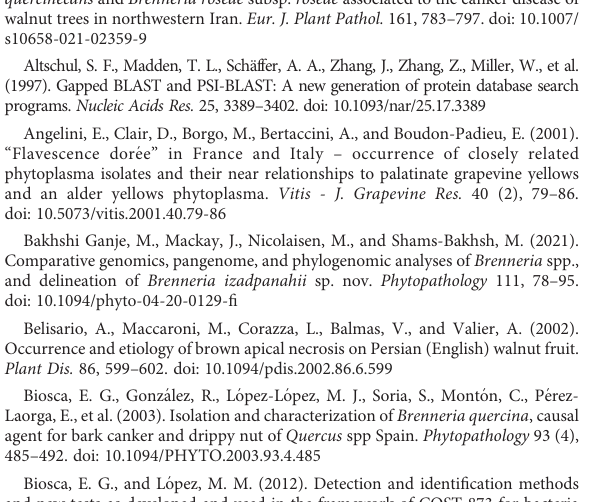
SUPPLEMENTARY FIGURE S1 Pathogenicity assay. Symptoms on walnut stem (A) two months after inoculation – no symptoms development on negative control (left), symptoms of tissue necrosis on the point of inoculation by the strain KBI 447. (B) 14 months after inoculation - no symptoms development on negative control (left), necrotic tissue under the bark extending deeper into the xylem (inoculation by the strain KBI 423) (middle and right). (C) Symptoms on young shoots three weeks after inoculation - no symptoms development on negative control (left), deep tissue necrosis around the point of inoculation (inoculation by the strain KBI